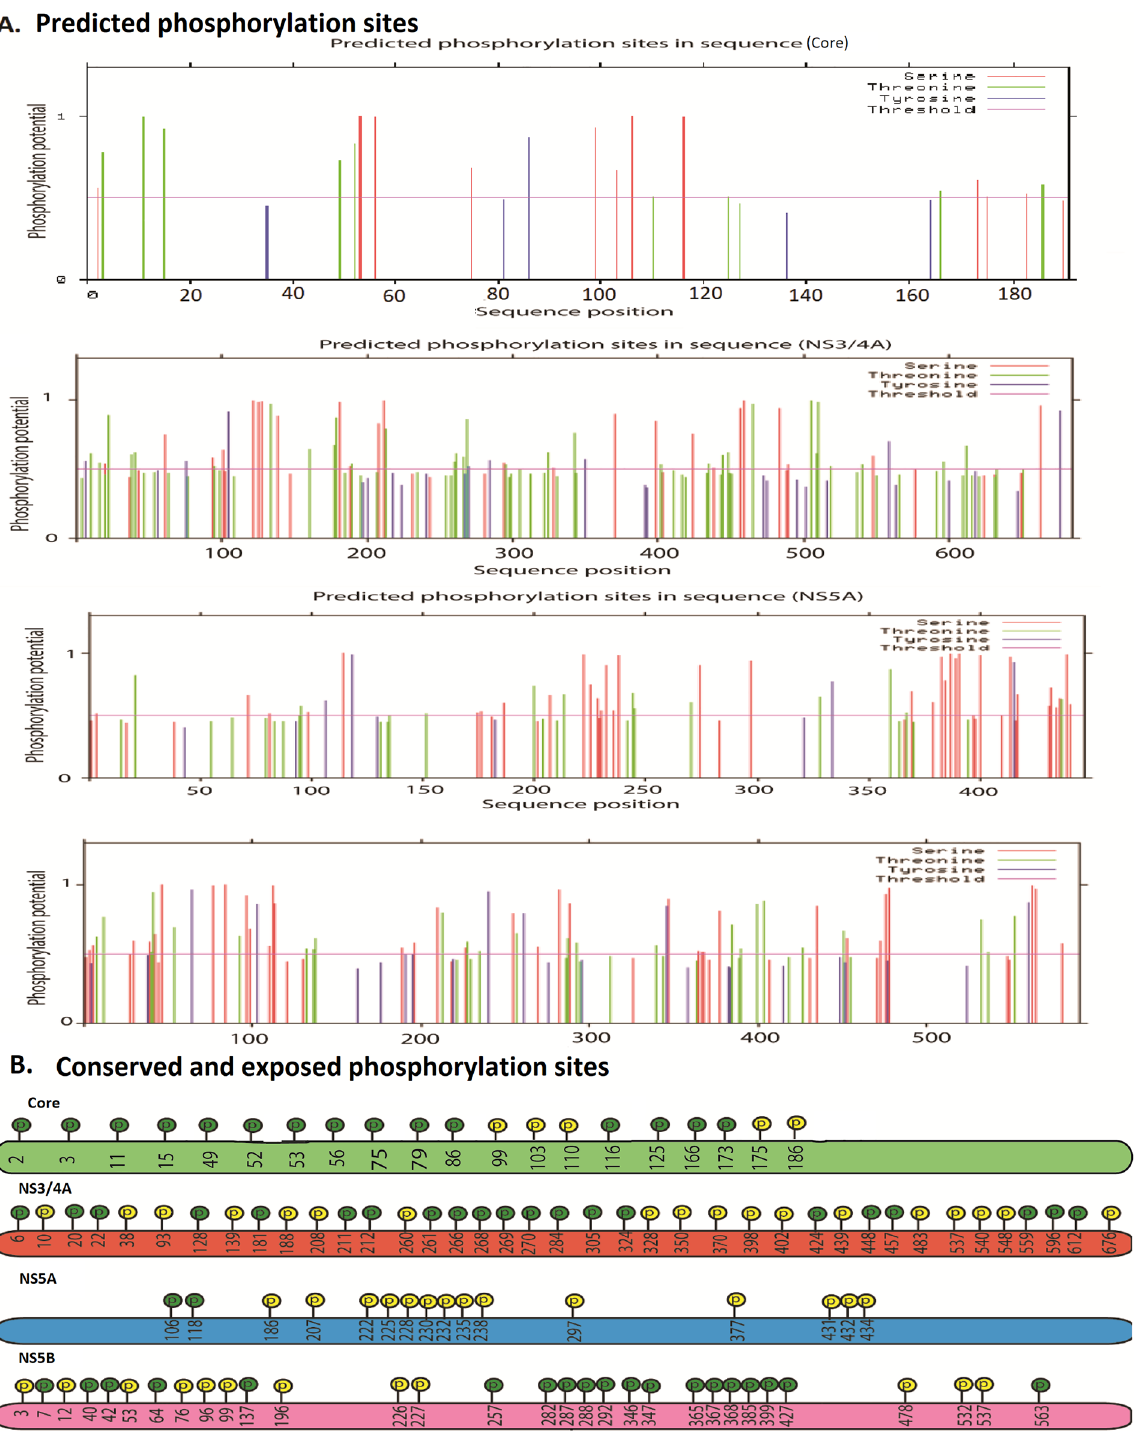
Figure 2. Predicted and conserved phosphorylation sites ( A ) A graphical presentation of all predicted phosphorylation sites within HCV Core, NS3/4A, NS5A and NS5B. ( B ) Conserved phosphorylation sites: yellow color phosphorylations sites are also exposed in viral